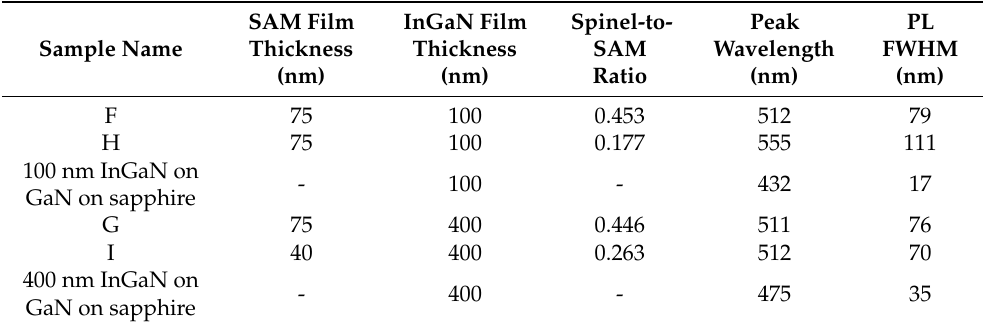
Table 3. PL results of InGaN film on SAM on sapphire substrates along with reference InGaN on GaN on sapphire